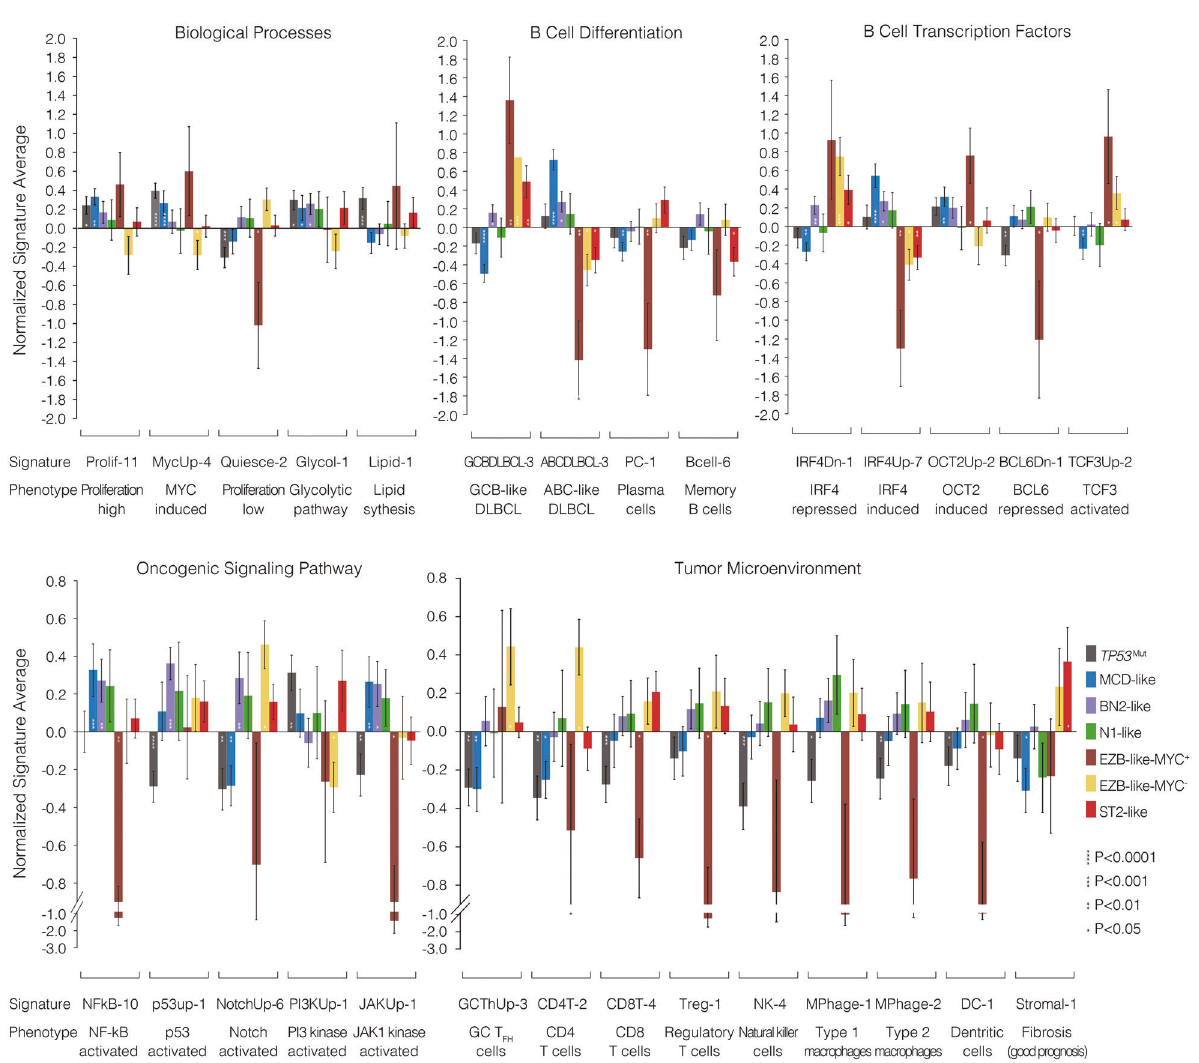
Fig. 5 Gene expression signature according to DLBCL genetic subtypes. Shown is average normalized expression of signature genes in each subtype versus other DLBCL samples in the Ruijin cohort ( n =